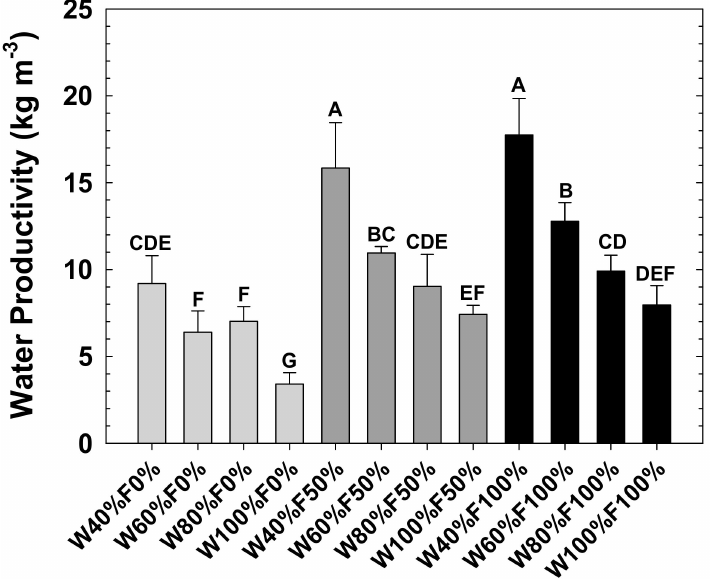
Figure 3. Water productivity (kg m − 3 ) as a function of irrigation and fertigation regime. Values with the same letter are not significantly different ( p <